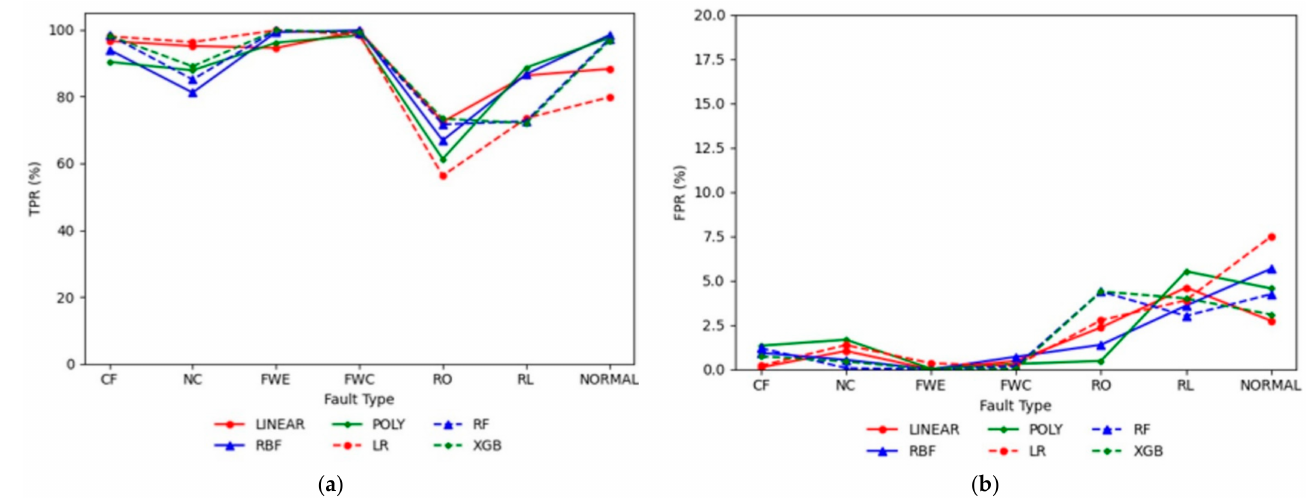
Figure 15. TPR and FPR values for each classification method (Case 3): ( a ) TPR; ( b ) FPR.